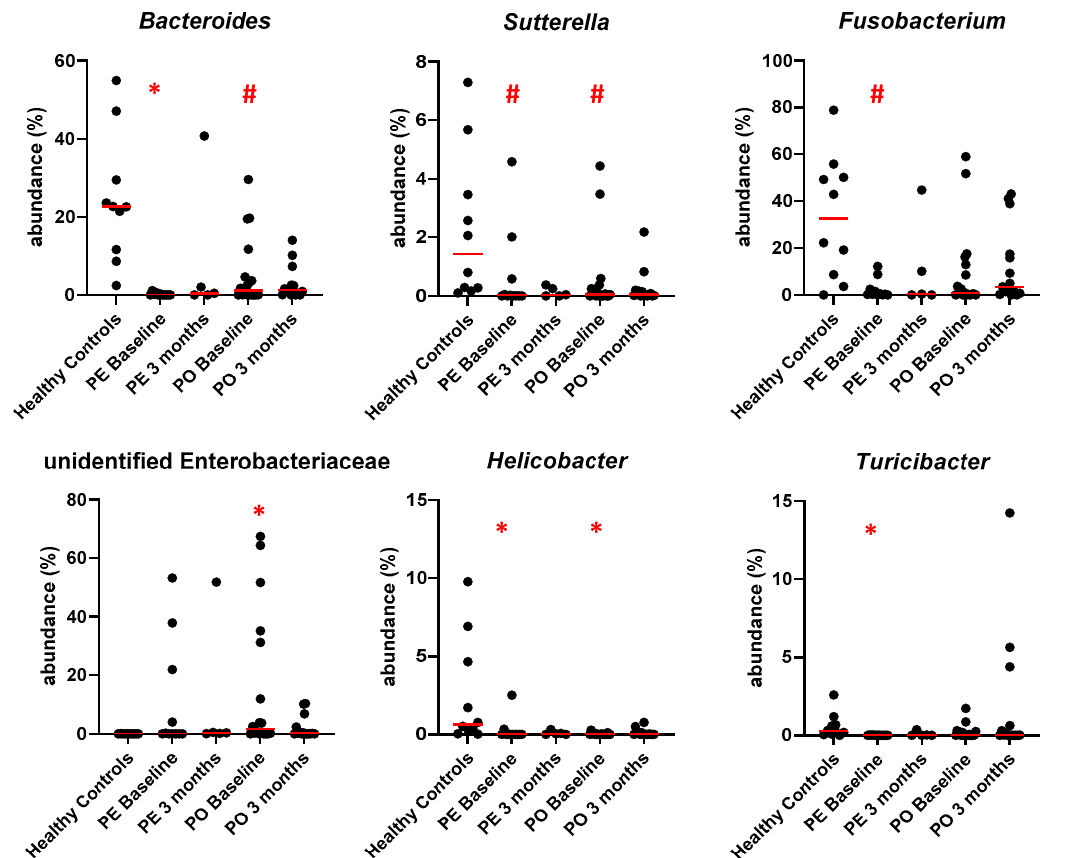
Figure 7. Abundance of key genera in healthy controls and in CE dogs with cobalamin deficiency separated by supplementation route, at baseline and after 3 months of cobalamin supplementation. PE indicates parenteral supplementation; PO indicates oral supplementation. Individual values are shown, and red lines indicate the median. * = q < 0.05; # = q < 0.1.